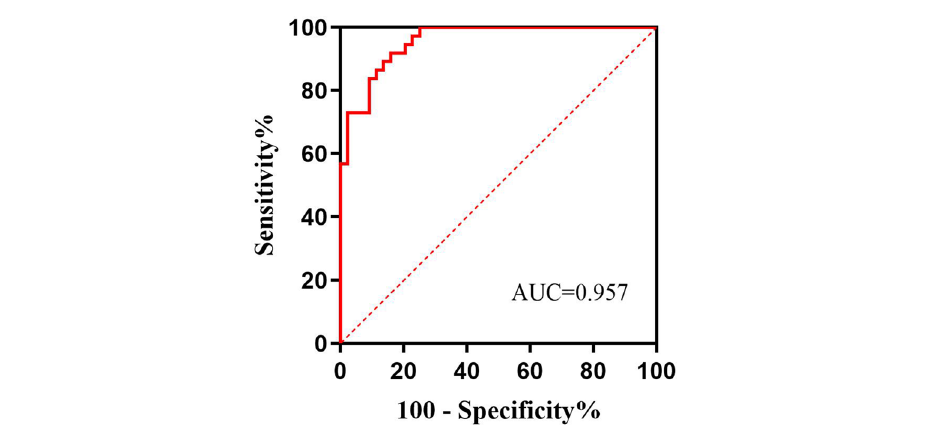
Fig. 2 Diagnostic efficacy of the Logit P model, Fajans’ index, Turner’s index and verification of two models. Fajans’ index = immunoreactive insulin/glucose; Turner’s index = insulin * 100/(glucose − 30). Liao’s model = 8.305–0.441 * insulin 2 h/0 h ratio − 1.679 * C-peptide 1 h/0 h ratio. FPG*HBA1C index = FPG*HBA1C. PPV, positive predictive value; NPV, negative predictive value; AUC, area under the curve; CI, confi- dence interval. # : Validated